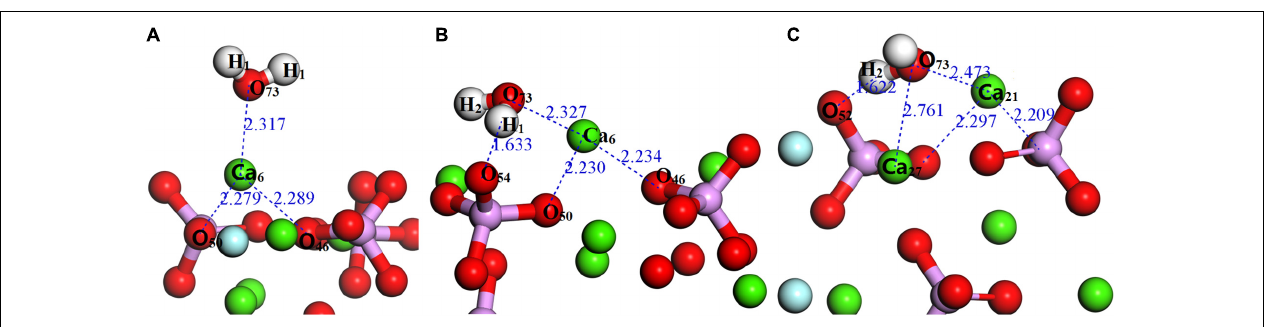
FIGURE 4 | Configurations of a single H 2 O molecule on the fluorapatite (001) surface: (A) single-adsorption; (B) double-site adsorption; (C) : three-site adsorption.